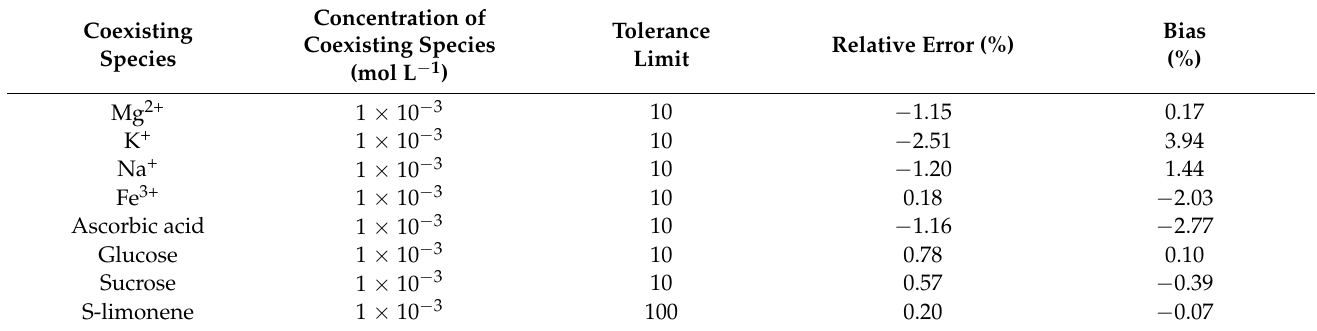
Table 2. The effect of coexisting species on the detection of 1 × 10 − 4 R-limonene (n = 5) using the TPP/AuNPs-S-Gr